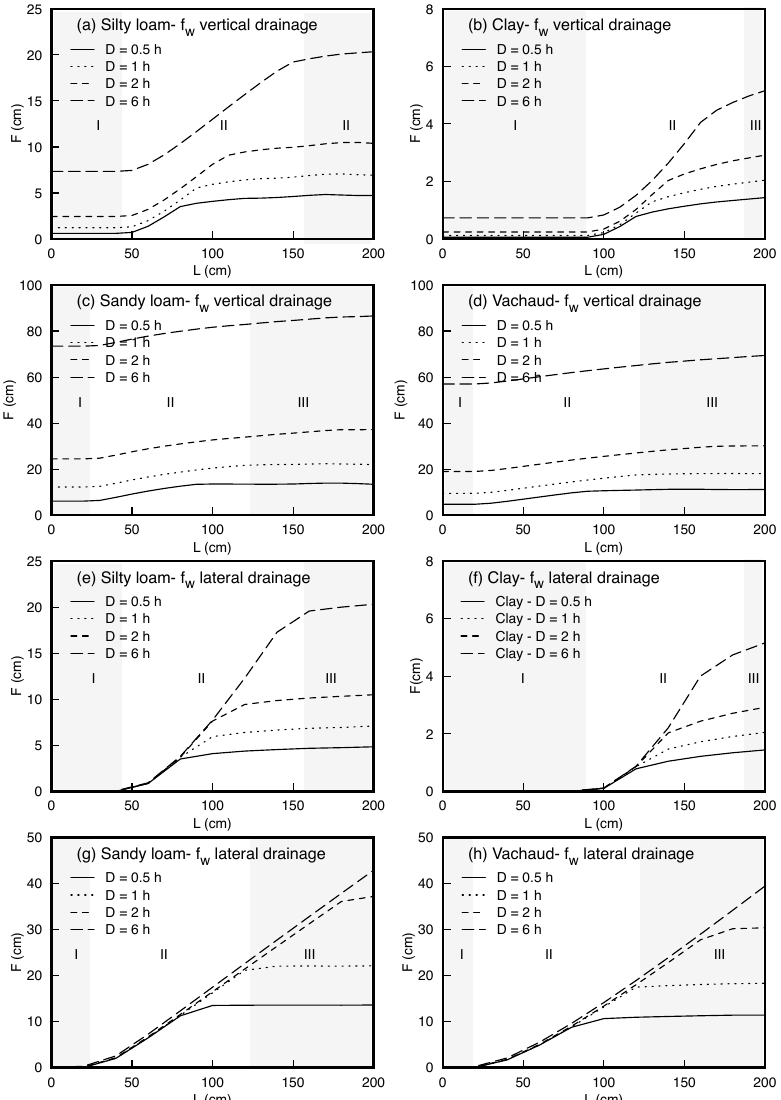
Figure 8. Effect of water table depth ( L) on cumulative infiltration ( F , represented by isolines) for distinct soils under initial ponding and different durations of infiltration events ( D) for four types of soils and two end drainage bottom boundary conditions ( f w ) : (a–d) vertical and (e–h) lateral ( S o = 0.02, b = 1m, and here K sh = K s from Table 1).